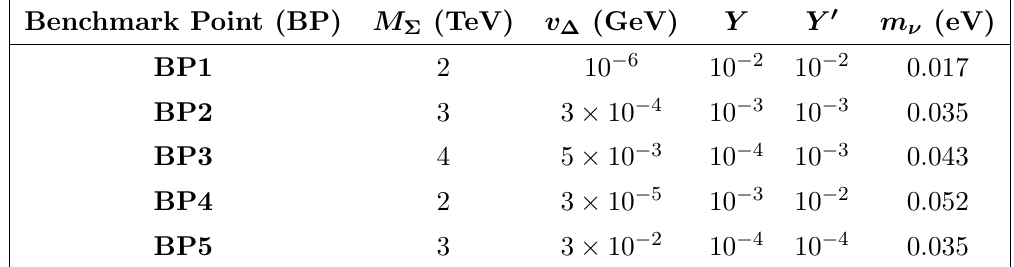
Table 2 . Order of neutrino mass for di(cid:11)erent values of Yukawa couplings Y and Y 0 for the representative values of M (cid:6) and v (cid:1) . Here v H = 174 GeV. operator induced neutrino masses, m tree